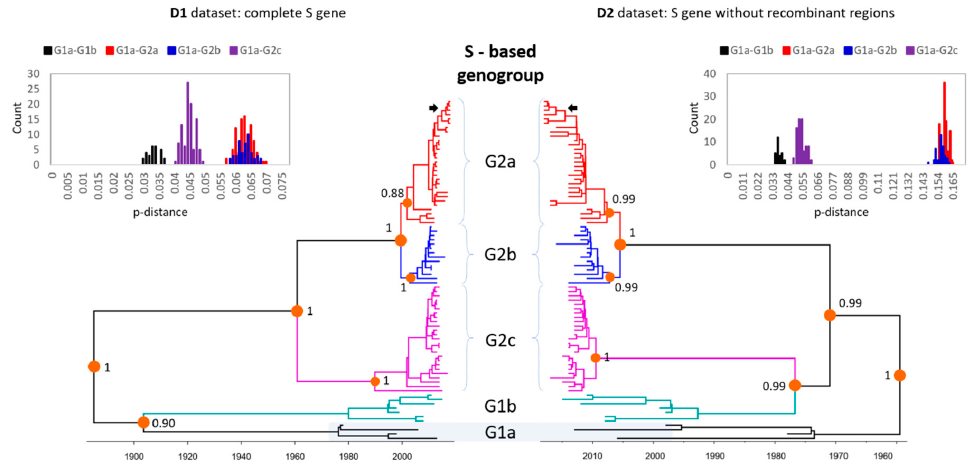
Figure 2. The time-scale maximum clade credibility phylogeny of global PEDV strains based on the S gene. The phylogenetic trees were constructed based on the S gene without removing the recombinant regions (D1) and with the recombinant regions removed (D2). The sub-genogroups were designated as G1a, G1b, G2a, G2b, and G2c. Each sub-genogroup was colored consistently sub-genogroups G1a–G1b, G1a–G2a, G1a–G2b, and G1a–G2c. The p -distance is calculated by dividing the number of nucleotide differences by the total number of nucleotides compared. After removing recombinant regions, some sequences might contain large deletions. In other words, the total number of nucleotides became smaller. Thus, the p -distance on the right panel was larger than that on the left panel. The Korean strains identified in this study are marked by arrows. Supported by high posterior probability values (0.90–1), the phylogenetic trees inferred from the D3–D4 datasets of the N gene (Figure 3, Supplementary Figure S3-S4) suggested that the classification of PEDV strains into four S gene-based sub-genogroups G1a, G1b, G2b, G2a/G2c was more reliable. In both datasets, it was observed that the S gene-based G2a and G2c were not monophyletic (pink branches). Differing from the S gene-based phylogenies (Figure 2), the Ngene-based trees with or without the elimination of recombinant regions had identical topologies of (G1a, (G1b, (G2b, G2a/G2c))). As the result, this study proposed an N-based genotyping of PEDV as N1, N2, N3b and N3a, which were equivalent to the S-based genotyping of G1a, G1b, G2b, and G2a/G2c, respectively. That classification was also supported by a clear bimodal distribution of genetic distance between the proposed genogroups N1–N2 and N1–N3a/N3b (inserted histograms, Figure 3). According to that scheme, the seven Korean strains identified in this study (S6, S10, S12, S14, S97, S100, and Y178) were within sub-genogroup N3a.